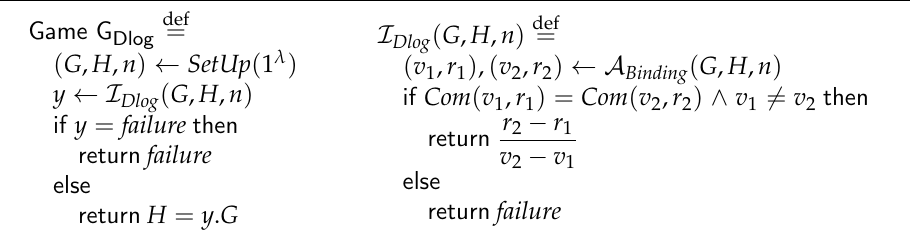
Figure 2. Game Inversor DLog.